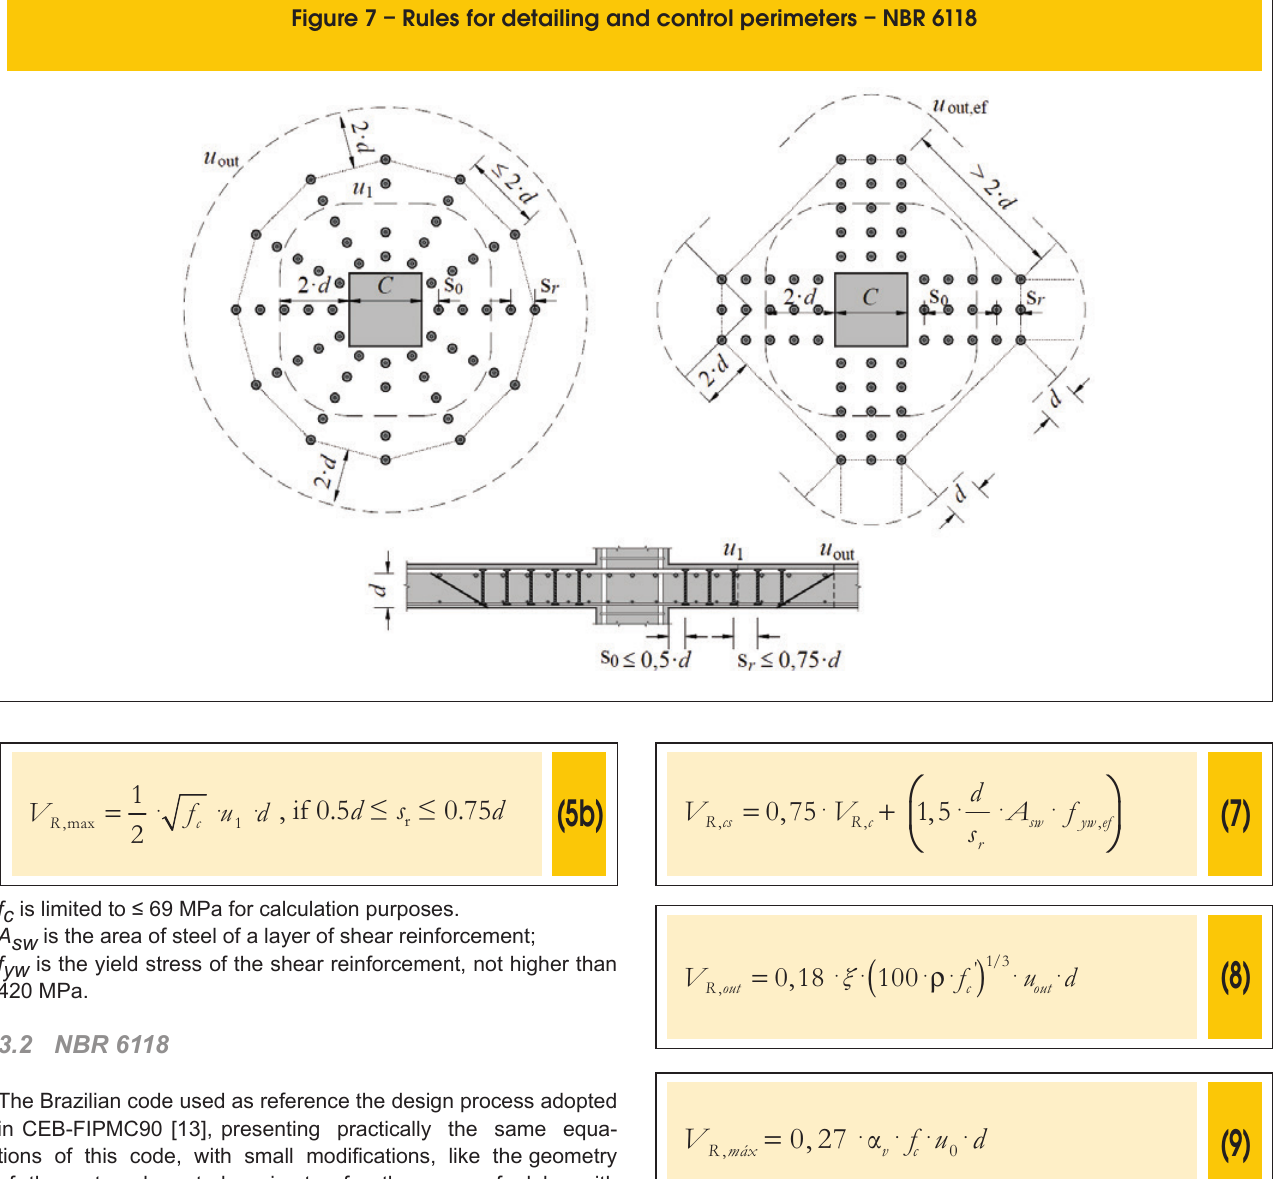
Figure 7 – Rules for detailing and control perimeters – NBR